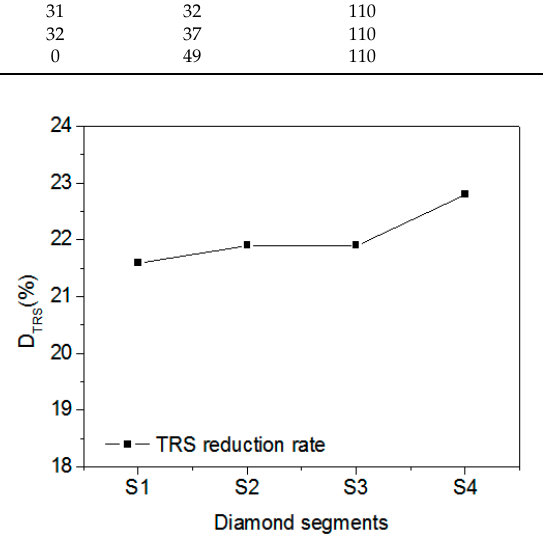
Table 7. Percent TRS reduction for different diamond distributions. Diamond Distribution